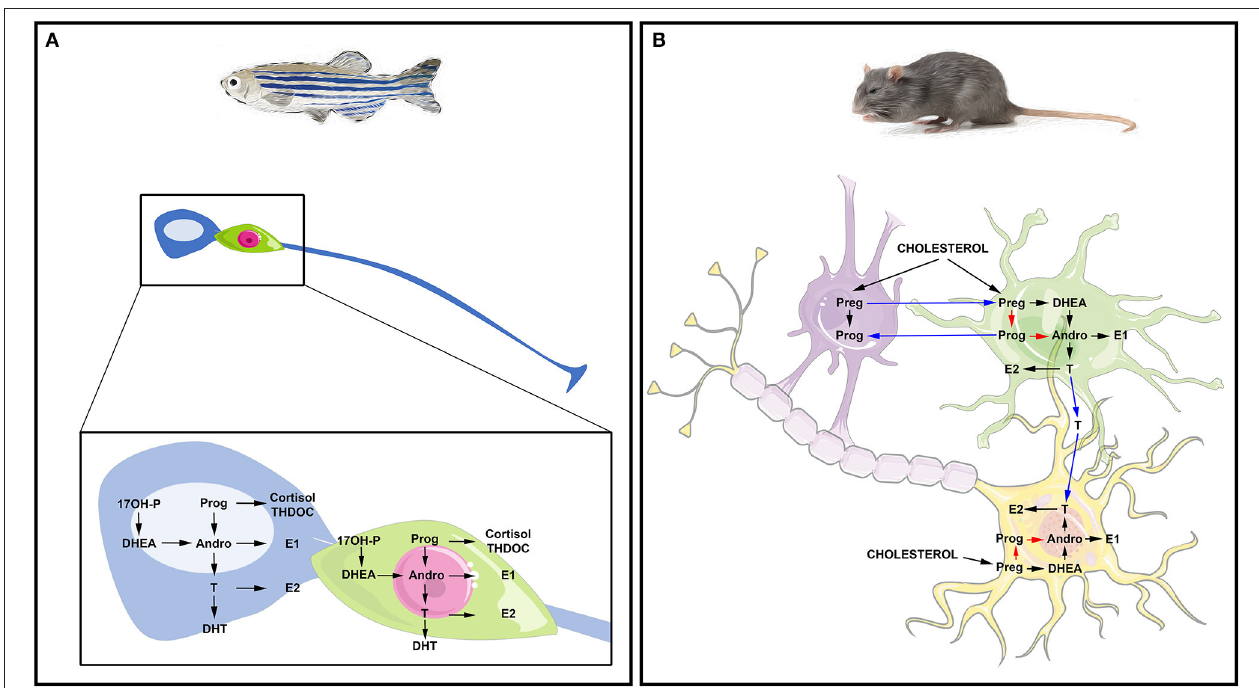
FIGURE 2 | Steroidogenesis in the brain of fish and mammals. (A) Steroidogenesis in the brain of adult fish. The blue cell corresponds to a radial glia cell acting as neural stem cell, while the green cell corresponds to a neuron. Data obtained by in situ hybridization, RNA sequencing and/or proteomics show neuronal and radial glial expression of steroidogenic enzymes involved in the synthesis of 17OH-Pregnenolone (17OH-P), Progesterone (P), dehydroepiandrosterone (DHEA), Androstenedione (Andro), Estrone (E1), 17 β -estradiol (17 β -E2, called here E2), testosterone (T) and dihydro-testosterone (DHT), cortisol and THDOC (tetrahydrodeoxycorticosterone). (B) Steroidogenesis in the brain of rat. The purple cell corresponds to an oligodendrocyte that participates in the myelin sheath genesis of axons; the green cell is an astrocyte and the yellow one is a neuron whose axon is myelinated by the oligodendrocyte. This schematic view adapted from Zwain and Yen (1999) highlights potential interaction of oligodendrocytes, astrocytes, and neurons in neurosteroidogenesis. The main steroidogenic pathway is shown by black arrows, the minor ones by red arrows and the suggested ones by blue arrows referring to the work of Zwain and Yen (1999). Note that arrows do not necessarily document the direct conversion of the one steroid into another, but can include several enzymatic